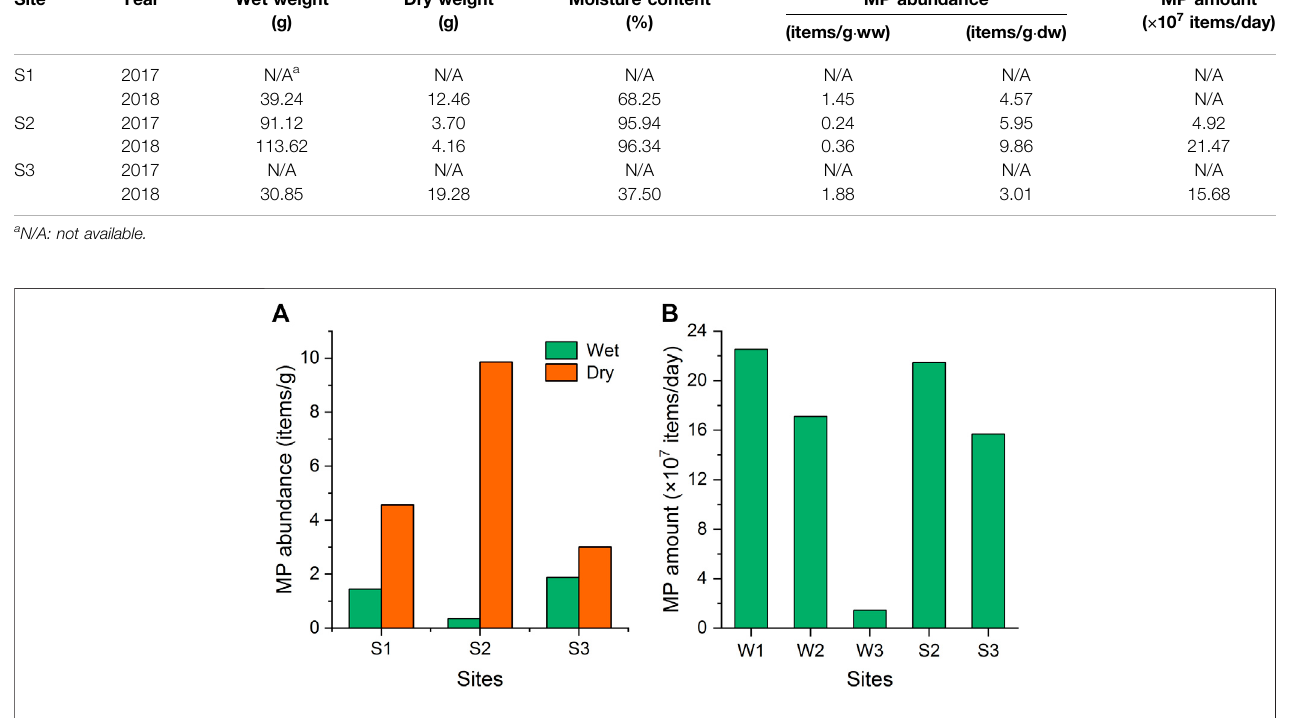
Frontiers in Environmental Science |